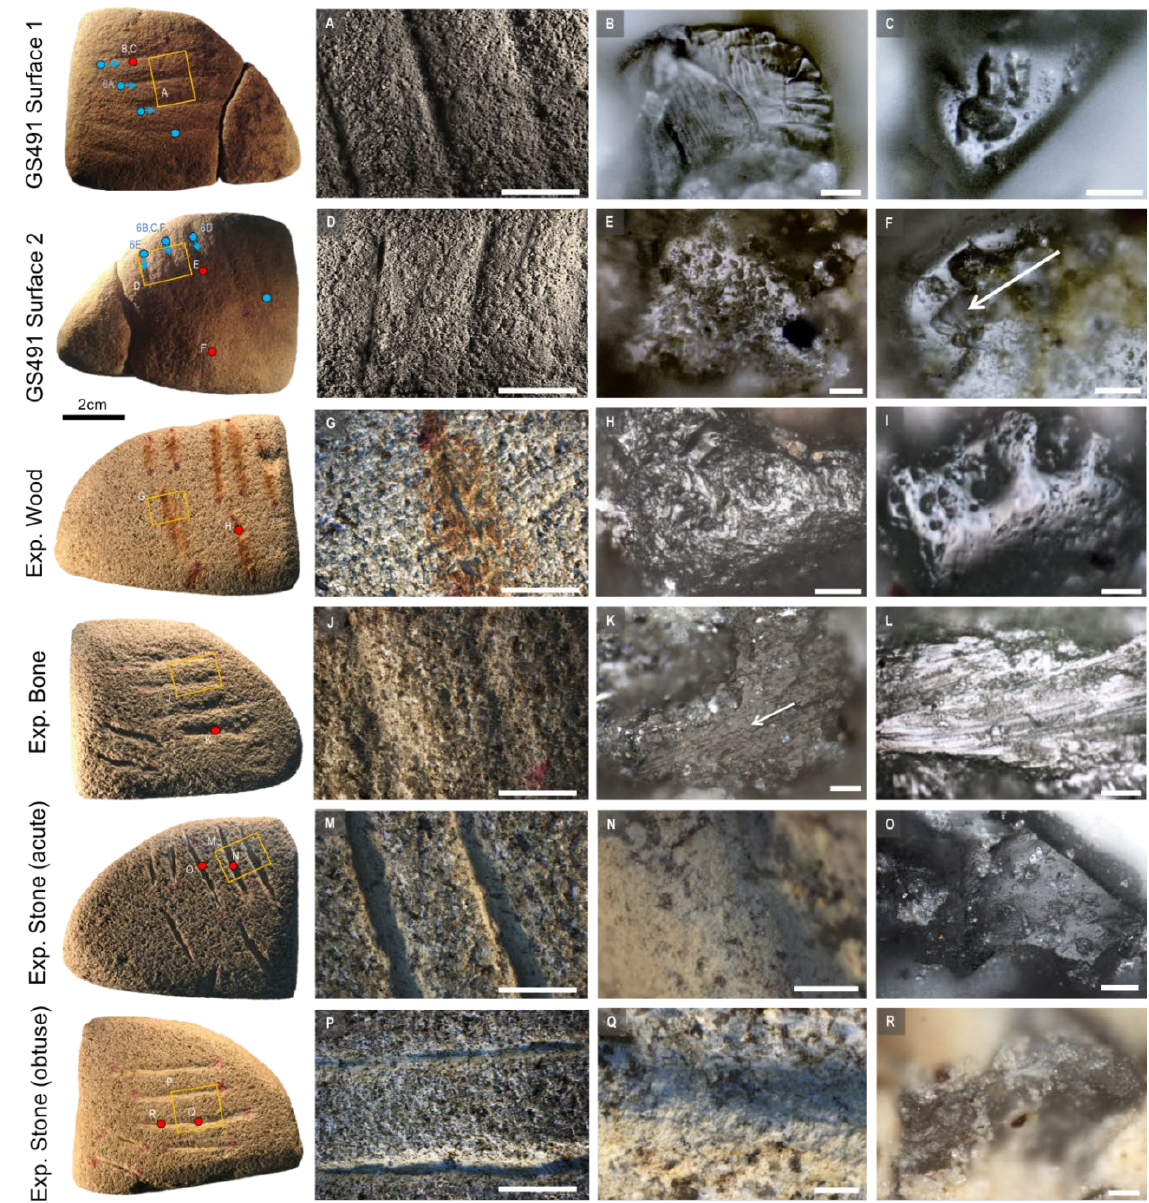
Figure 5. Use-wear documented on GS491 and experimental tools including detail of grooves and quartz grains polish, scarring and residues (indicated by red dot). A-C) Use-wear on GS491 Surface 1, note the polish and micro-scarring on quartz grain from inside the groove (B) and outside the groove (C); D-F) Use-wear on GS491 Surface 2, including micro-scarring (indicated by arrow) and a reticulated use-polish on individual grain, similar to siliceous plant processing; G-H) Use-wear on experimental tool incised with wood; polish is weakly developed showing and even, grainy texture with some connectivity but only very early stages of a reticular pattern but not diagnostic of worked material; I) Use-wear on experimental sandstone tool used for sharpening wood for 2 hours, note the developed reticulated polish; J-K) Use-wear on experimental tool incised with bone; L) Use-wear on experimental sandstone tool used for sharpening bone for 2 hours, note the striated polish; M-O) Use-wear on experimental tool incised with an acute-edged flint flake with straight grooves with a V cross section and fractured grains; P-R) Use-wear on experimental tool incised with obtuse-edged flake, grooves are straight and shallow with U cross section. Scale bars: detail of grooves (A,D,G,J,M,P): 5mm, (N,Q) 0.5mm; micro-graphs: 20µm. Residue extraction locations indicated by blue dot on tool